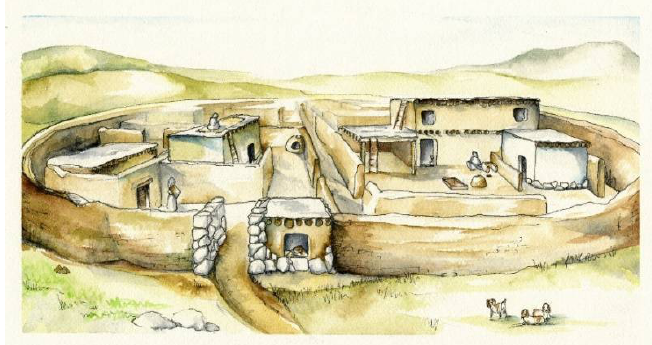
Figure 18. Artistic reconstruction of Late Chalcolithic Çadır Höyük. The authors invite viewers to imagine the unseen deposits concealed within the built spaces, ensuring every centimeter evoked emotion, carried meaning, and stored memories for those who inhabited this ancient settlement (drawing by L. Hackley).